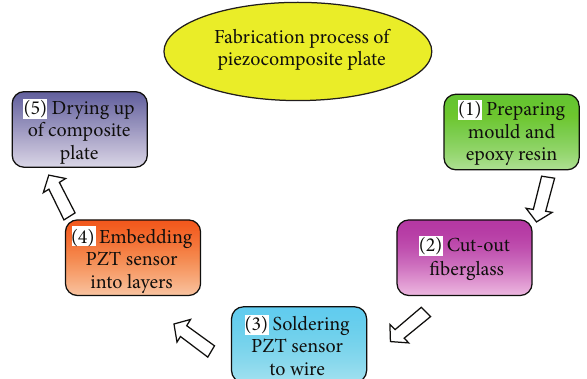
Figure 2: Flowchart of fabrication process of piezocomposite plate.